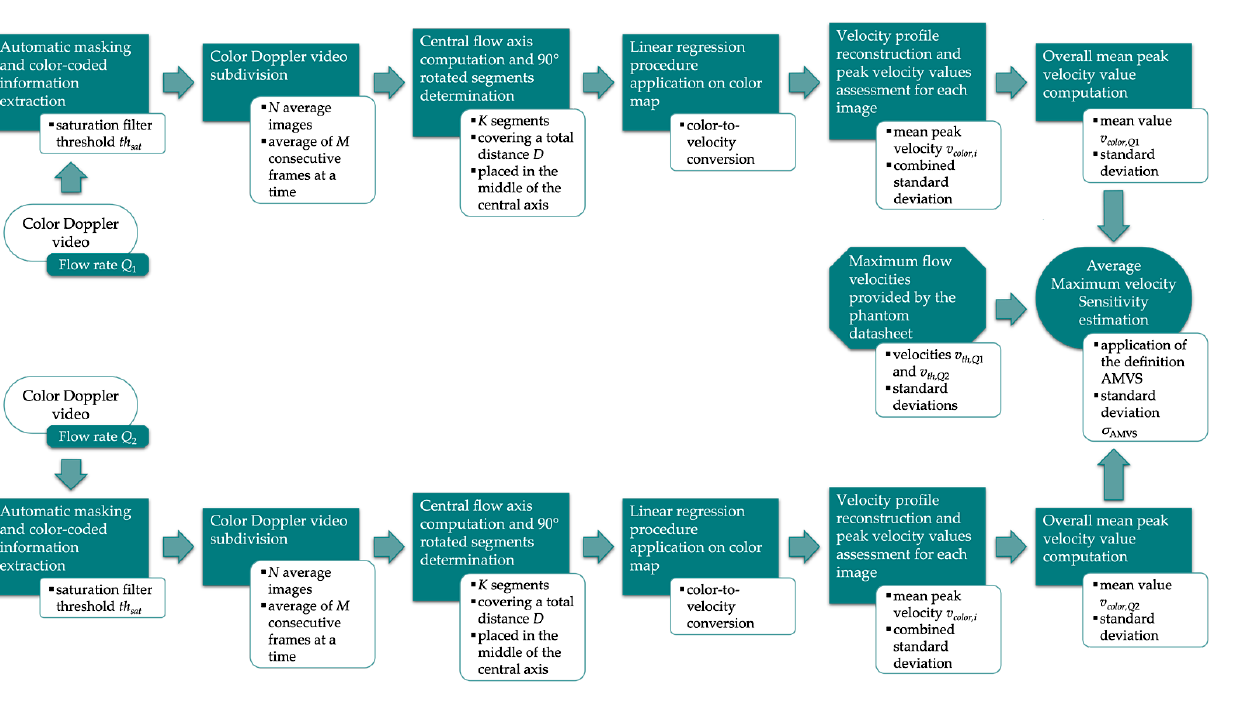
Figure 5. Flow chart of the image analysis-based method for AMVS parameter estimation.